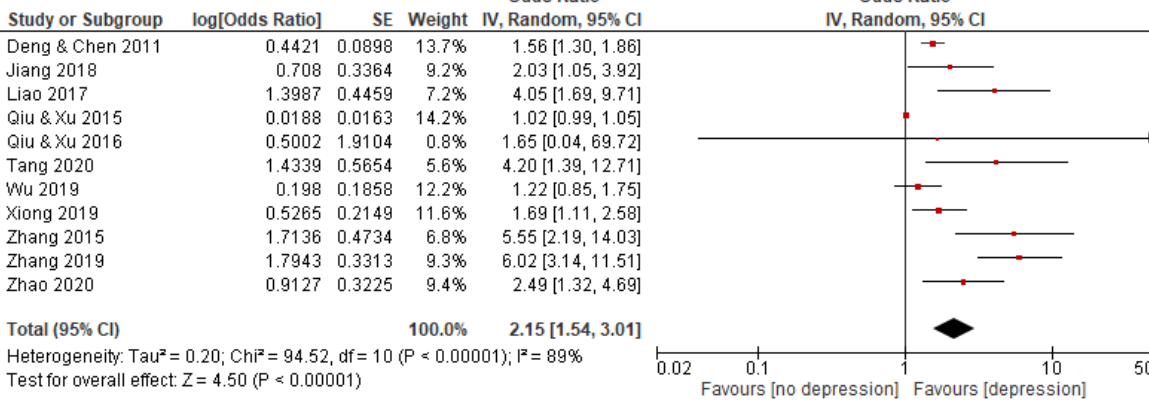
Figure 3. Forest plot of studies on association between QDC and depression. Note: red square represents the result of each study; line represents the 95% CI of the results; diamond represents the pooled results.